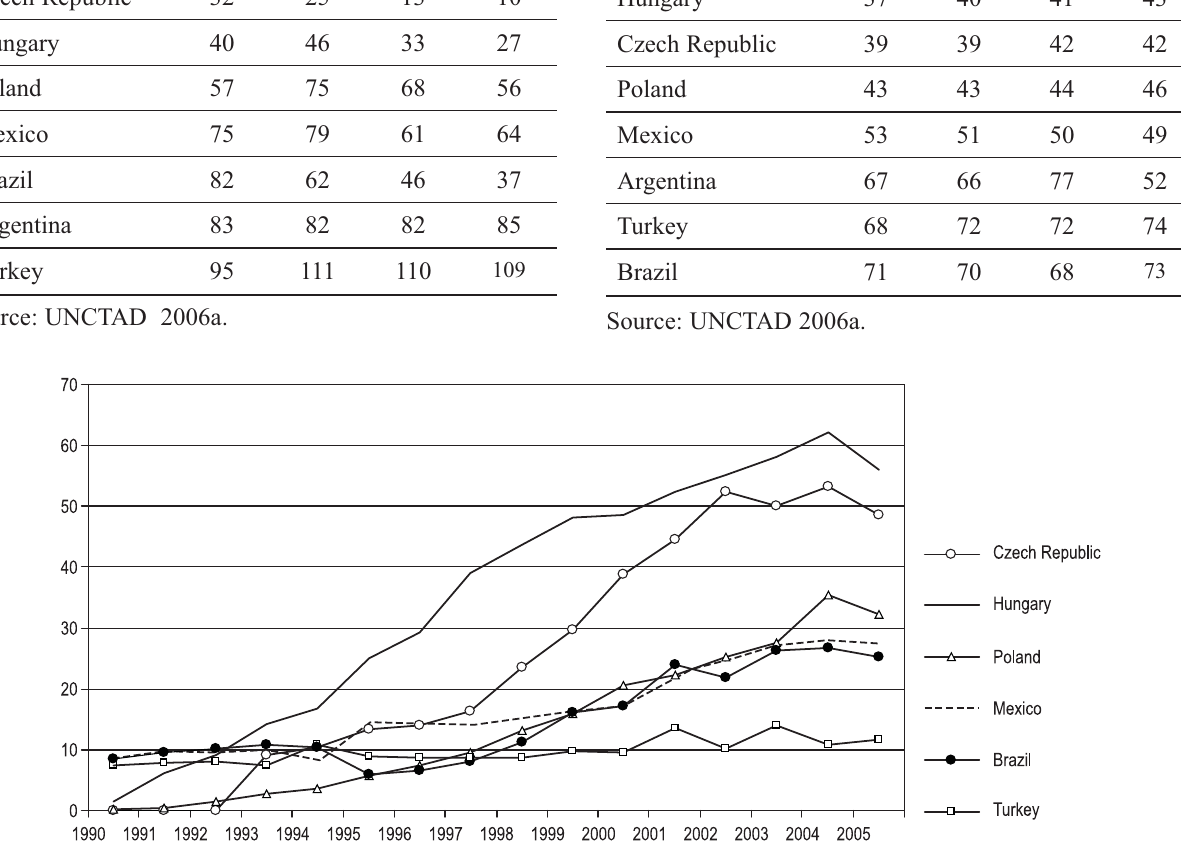
Fig. 1. Inward FDI Stock as percentage of GDP in Selected Emerging Economies Source: UNCTAD